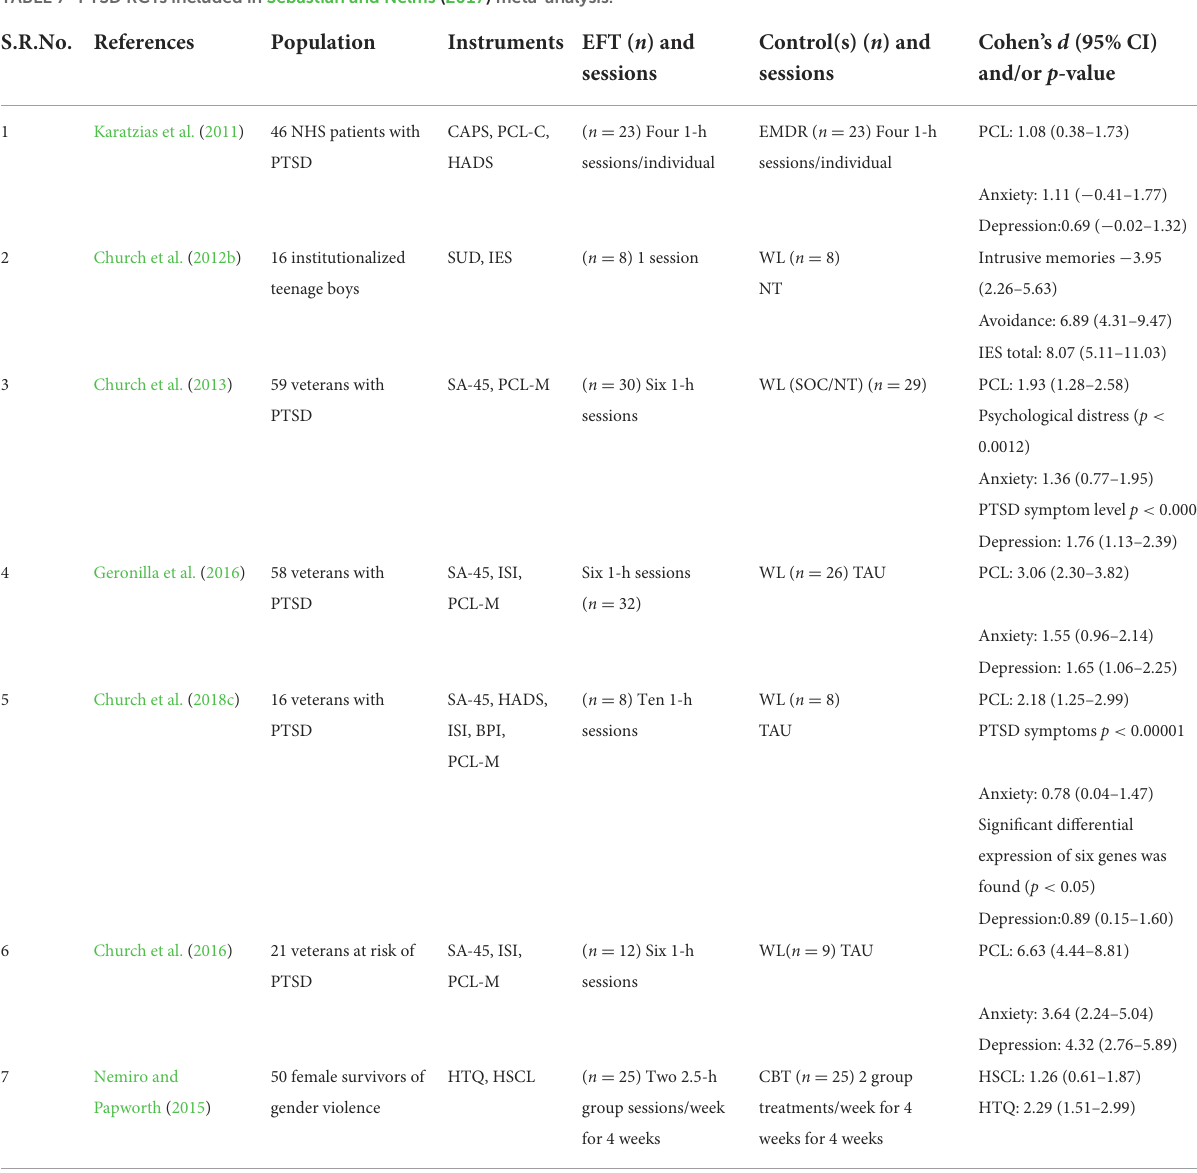
TABLE 7 PTSD RCTs included in Sebastian and Nelms (2017)